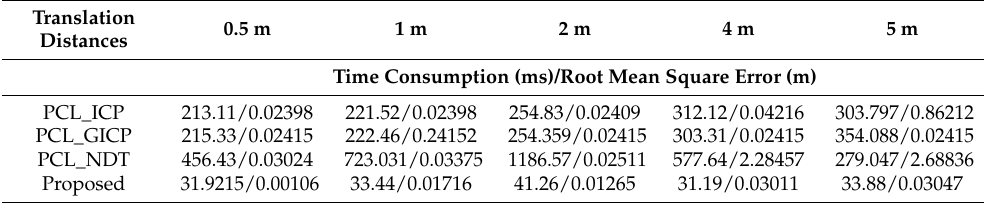
Table 3. Registration results of different algorithms for point clouds with different translation